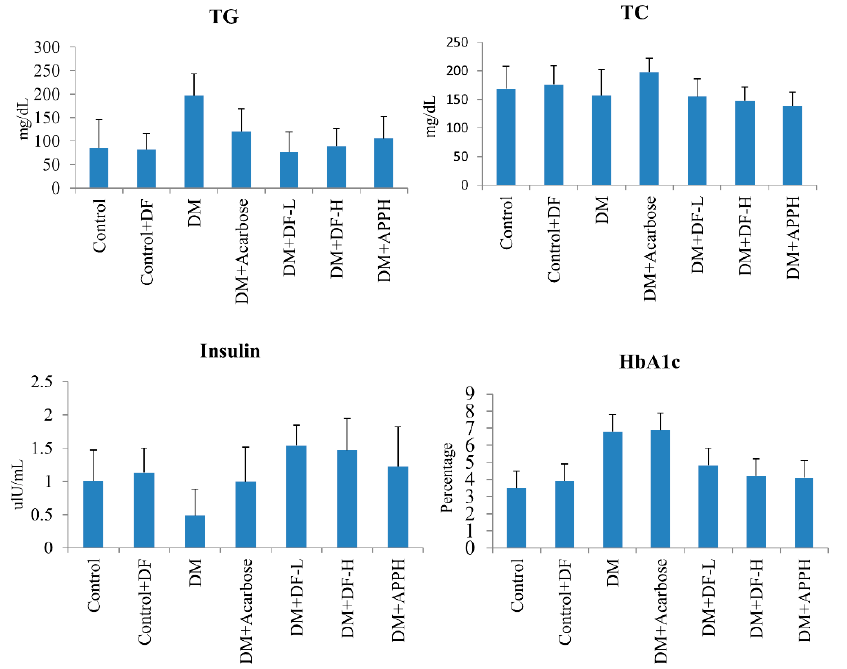
Figure 3. Effects of DF peptide on biochemical changes in the blood plasma. The results of a biochemical analysis show the difference in plasma triglycerides (TG), total cholesterol (TC), insulin, and HbA1c in non-diabetic controls (Control), non-diabetic mice treated with DF (Control+DF), STZ-induced diabetes mellitus mice (DM), DM mice treated with acarbose (DM+Acarbose), DM mice treated with low-dose DF peptide (DM+DF-L), DM mice treated with high-dose DF peptide (DM+DF-H), and DM mice treated with APPH peptide